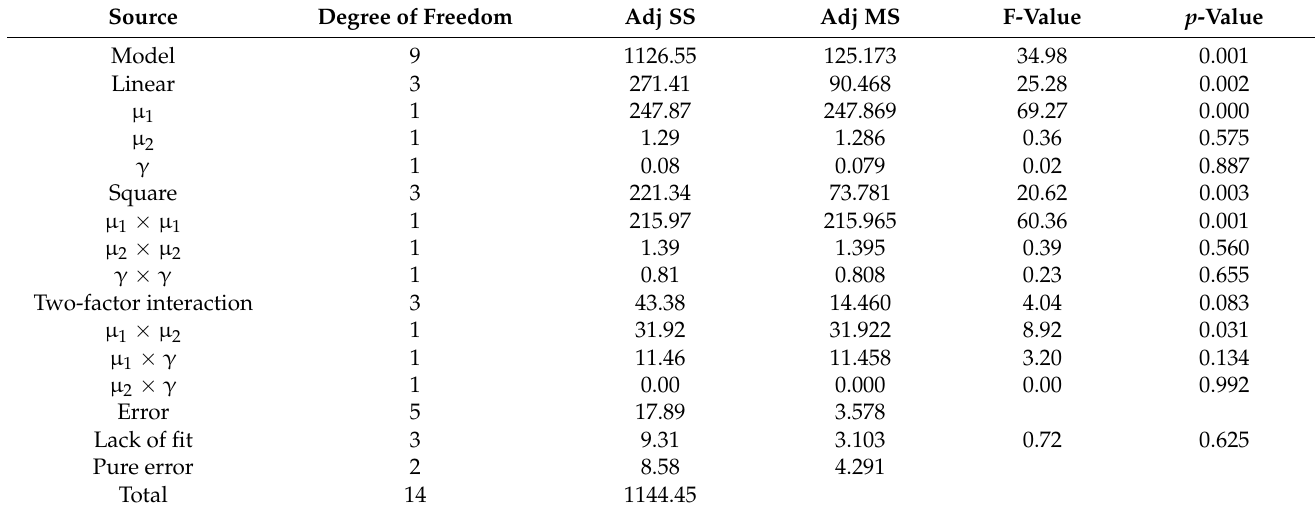
Table 5. Analysis of variance for BBD test.